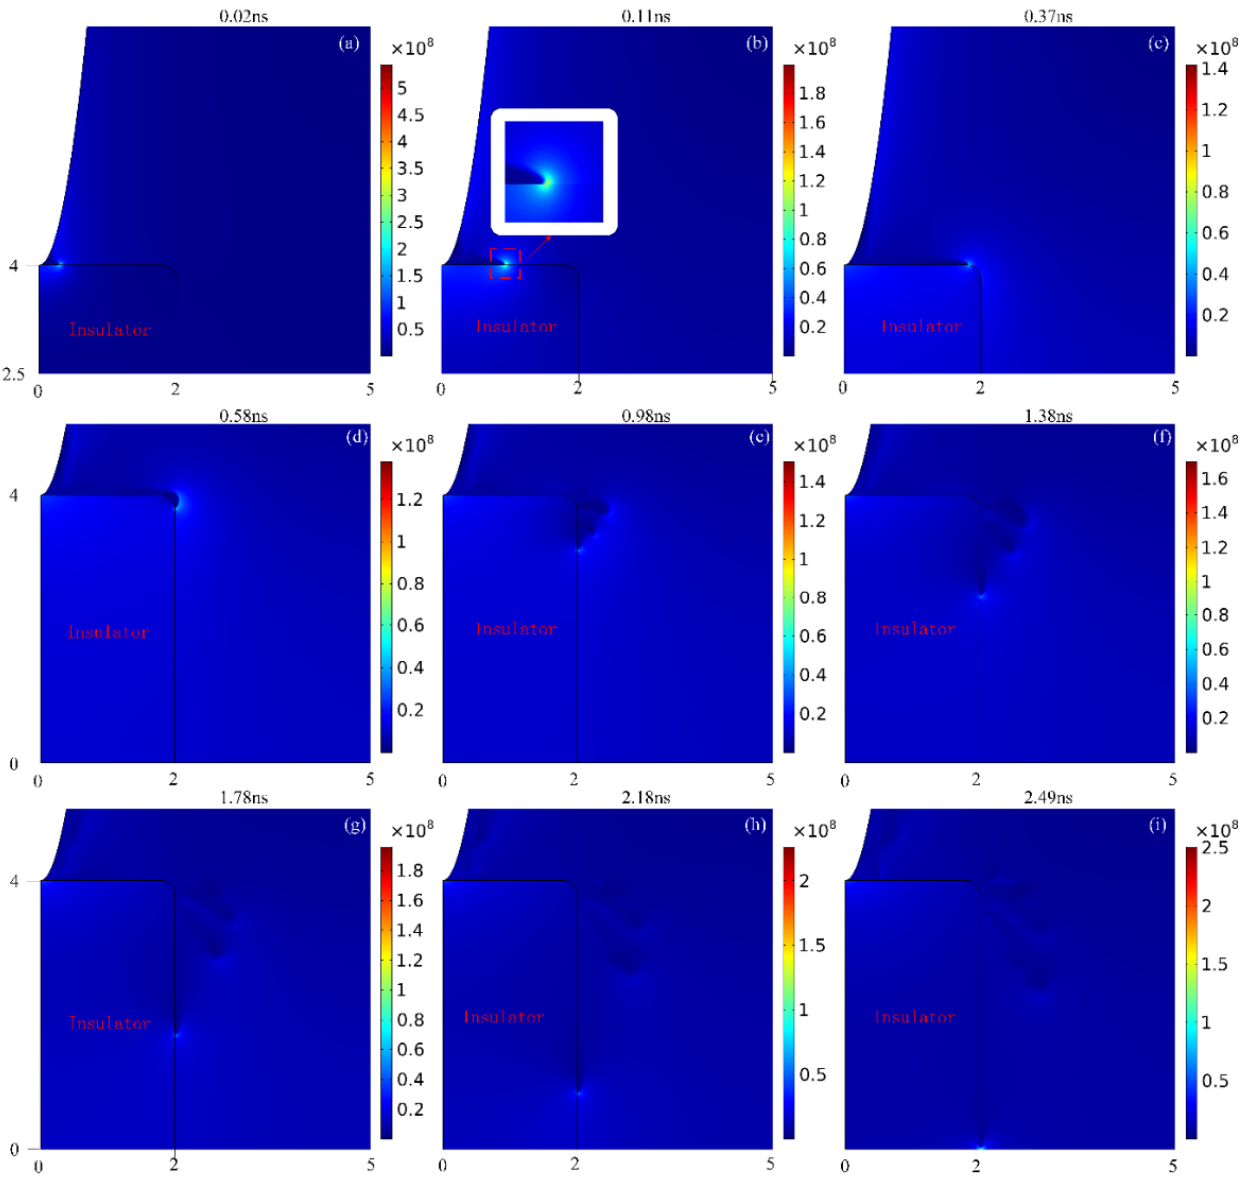
Figure 5. Electric field changes during streamer development. After that, the streamer enters the transition stage, from the upper surface of the insulator to the right surface. This stage has the slowest development speed. And the electric field at the streamer head is also the smallest, because the distance from the needle